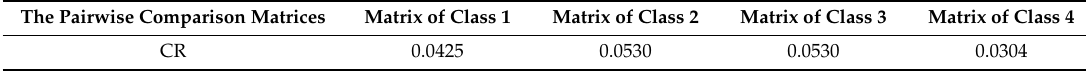
Table 11. The consistency test of each